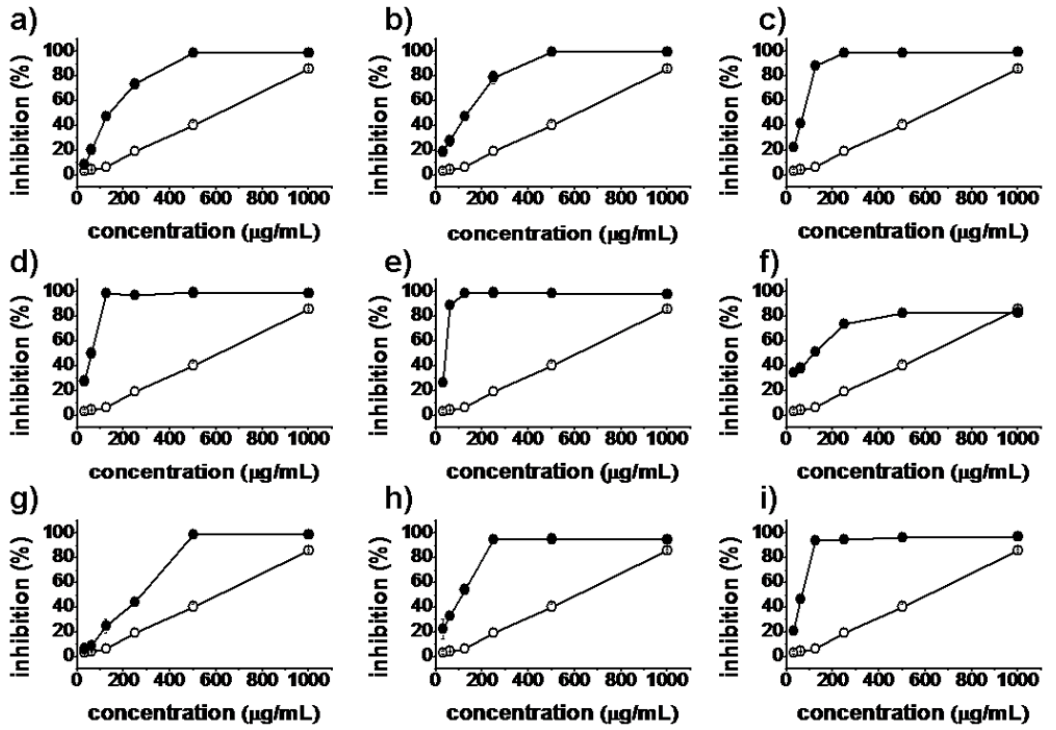
Figure 2. Inhibition percentages of 5a – i ( a – i , respectively) against A375 cells at concentrations of 31.25, 62.5, 125, 250, 500, and 1,000 μ g/mL. Matrine ( ), synthesized compounds ( ). Results are expressed as the mean ± SD of data obtained from three independent